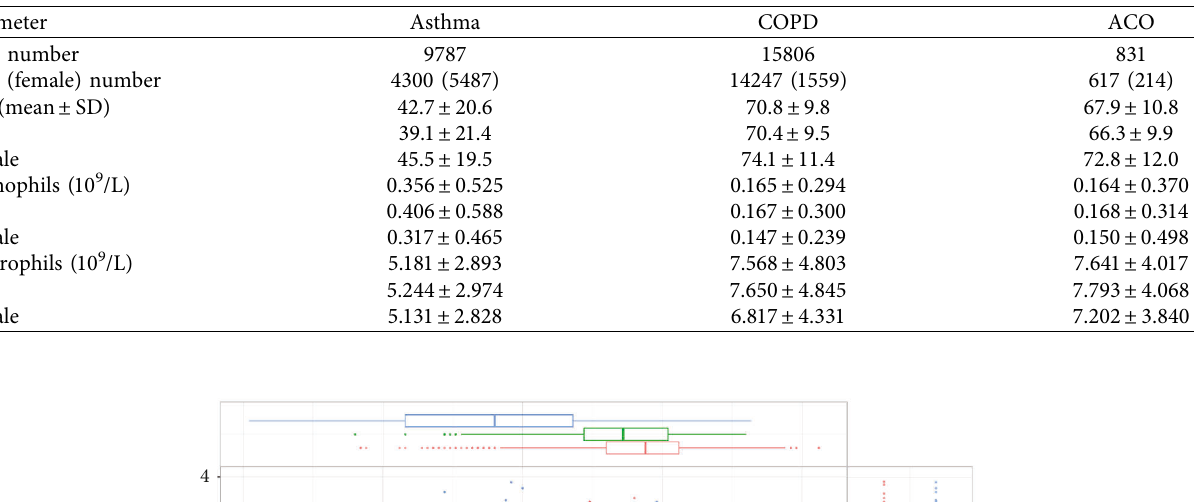
Table 1: Baseline characteristics of participants (COPD: chronic obstructive pulmonary disease; ACO: asthma-COPD overlap; SD: standard deviation).